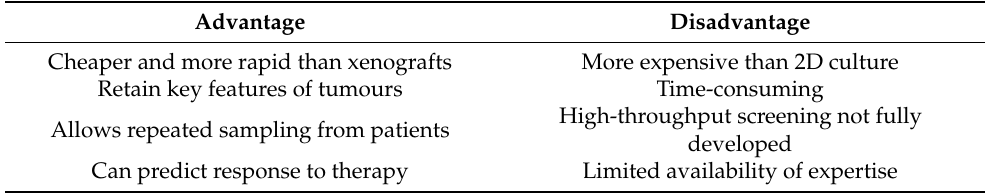
Table 1. Advantages and disadvantages of the more common methods of establishing patient-derived organoids. Advantage Disadvantage Cheaper and more rapid than xenografts More expensive than 2D culture Retain key features of tumours Time-consuming High-throughput screening not fully Allows repeated sampling from patients developed Can predict response to therapy Limited availability of